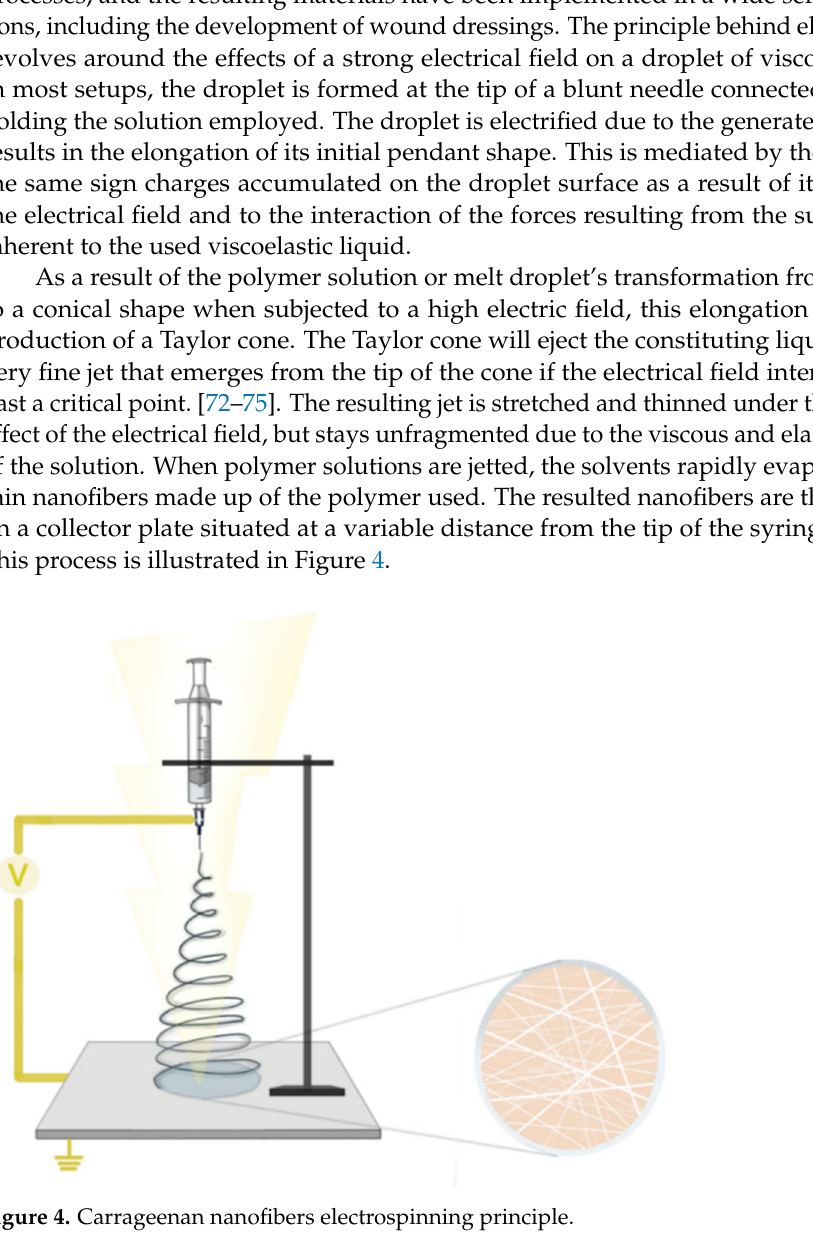
Figure 4. Carrageenan nanofibers electrospinning principle.